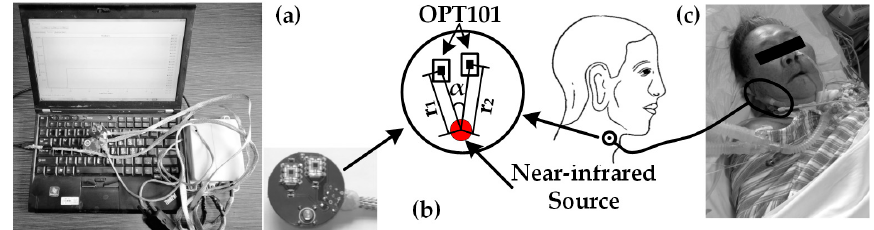
Figure 4. Shock monitoring: ( a ) actual device for shock; ( b ) the probe for shock; ( c ) picture of clinical experiment test scene.